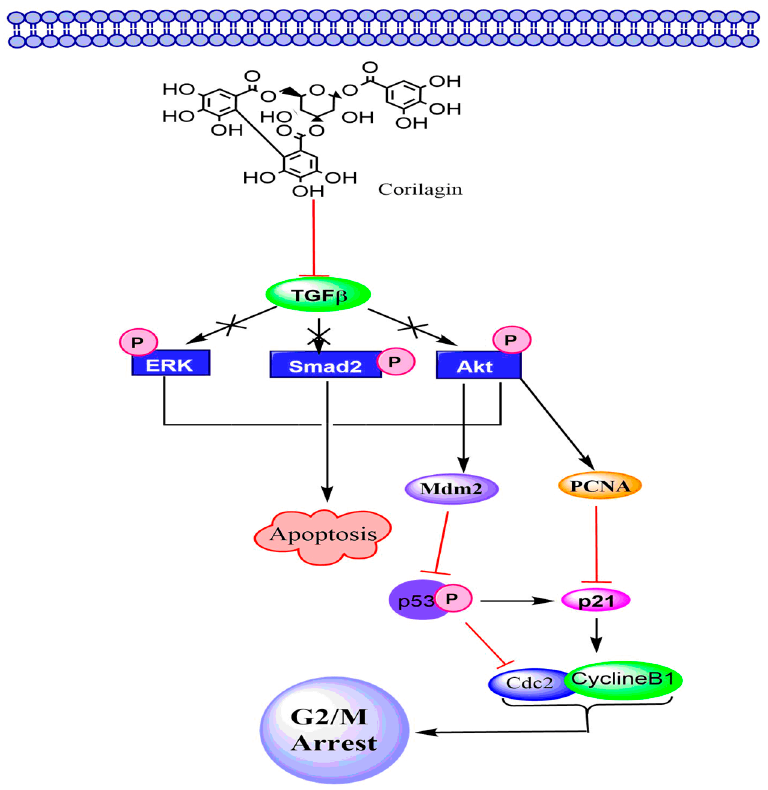
Figure 4. The effect of corilagin on the TGF- β signaling pathway in ovarian cancer. Figure 4. The e ff ect of corilagin on the TGF- β signaling pathway in ovarian